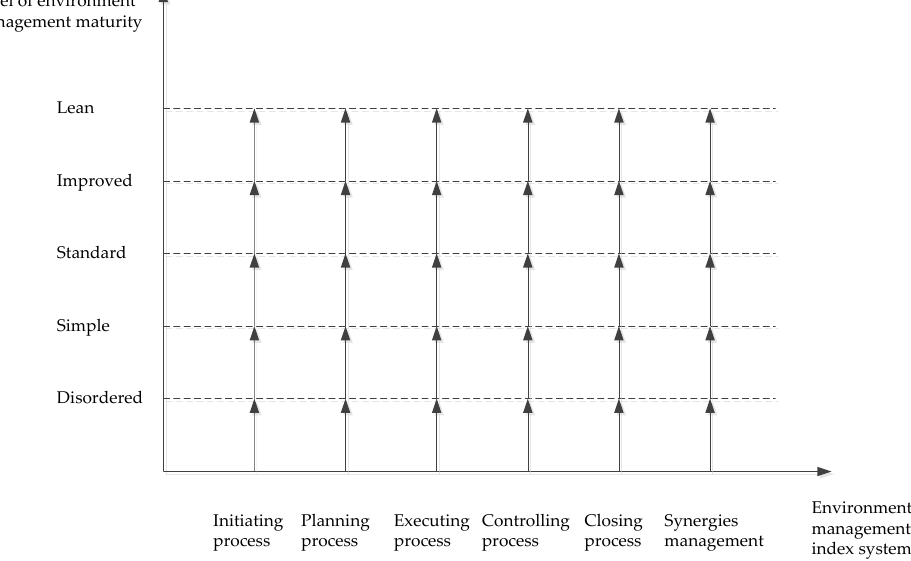
Figure 2. Dimensions of the Environmental Management Maturity Model of Construction Program (EMMMCP).